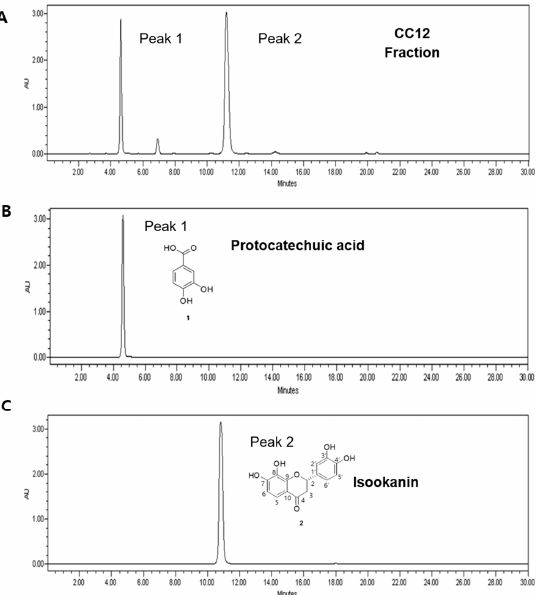
Figure 2. ( A ) HPLC profiles of sub-fraction (CC12) separated by column chromatography. Use of preparative HPLC to yield ( B ) single compound 1 protocatechuic acid and ( C ) compound 2 isookanin. 2.2. Effect of Isookanin on NO and PGE 2 Production in LPS-Induced RAW 264.7 Cells To evaluate the inhibitory effect of isookanin on the production of proinflammatory mediators, we measured the production of NO and PGE 2 in the LPS-stimulated RAW 264.7 cells and cell viability studies were first conducted to confirm the cytotoxic effects of isookanin administration. RAW 264.7 cells were pretreated with isookanin for 2 h, and then stimulated with LPS (100 ng/mL) for 24 h. The cell viability measured using the EZ- Cytox ™ reagent and the results demonstrated that isookanin did not cause cytotoxicity to the RAW 264.7 cells at concentrations ranging from 1 to 10 μ g/mL, which could be used in further studies (Figure 3A). Treatment with LPS alone significantly increased the levels of NO, whereas isookanin dose-dependently decreased the LPS-induced NO production in RAW 264.7 cells (Figure 3B) and 1400 w (500 nM) was used as a positive control as a NO inhibitor. LPS stimulation also increased PGE 2 production, but isookanin effectively inhibited the generation of PGE 2 induced by LPS (Figure 3C). Celecoxib (0.1 nM) was used as a positive control as a PGE 2 inhibitor and when 10 μ g/mL of isookanin was treated, the PGE 2 inhibitory effect was similar to that of the positive control group. The NO and PGE 2 inhibitory effects of isookanin at 10 μ g/mL were 72% and 57%, respectively. These results demonstrate that isookanin exhibits an anti-inflammatory effect by inhibiting proinflam- matory mediators in LPS-stimulated RAW 264.7 cells.